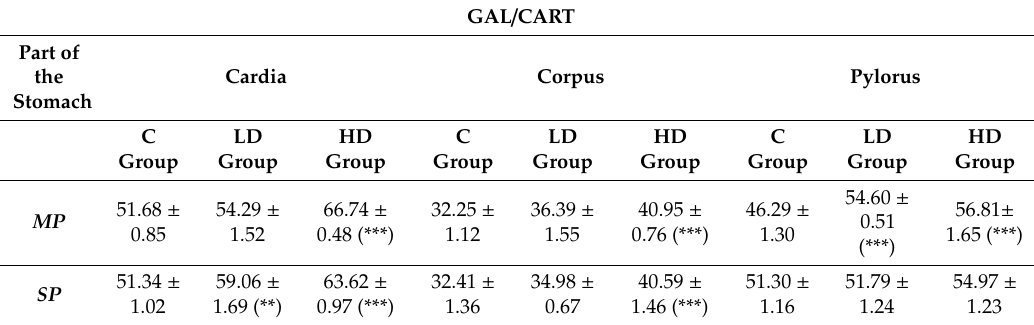
Table 4. Co-localization of GAL with cocaine- and amphetamine-regulated transcript (CART) in the enteric neurons in various parts of the porcine stomach under physiological conditions (C group) and after low dose (LD group) or high dose (HD group) of acrylamide administration.